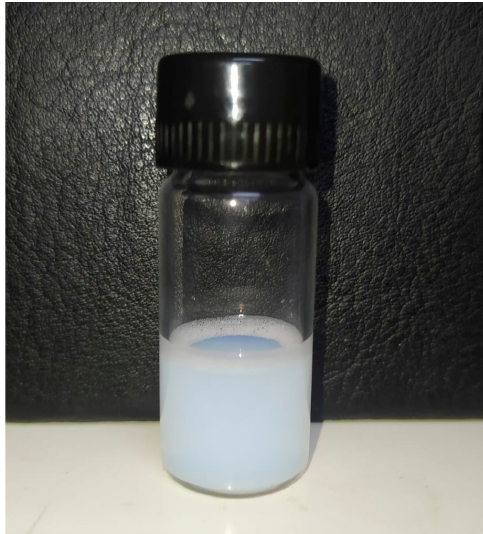
Figure 1. Nanoemulsion: bluish-white color characteristic of the Tyndall effect with 2% of NE.